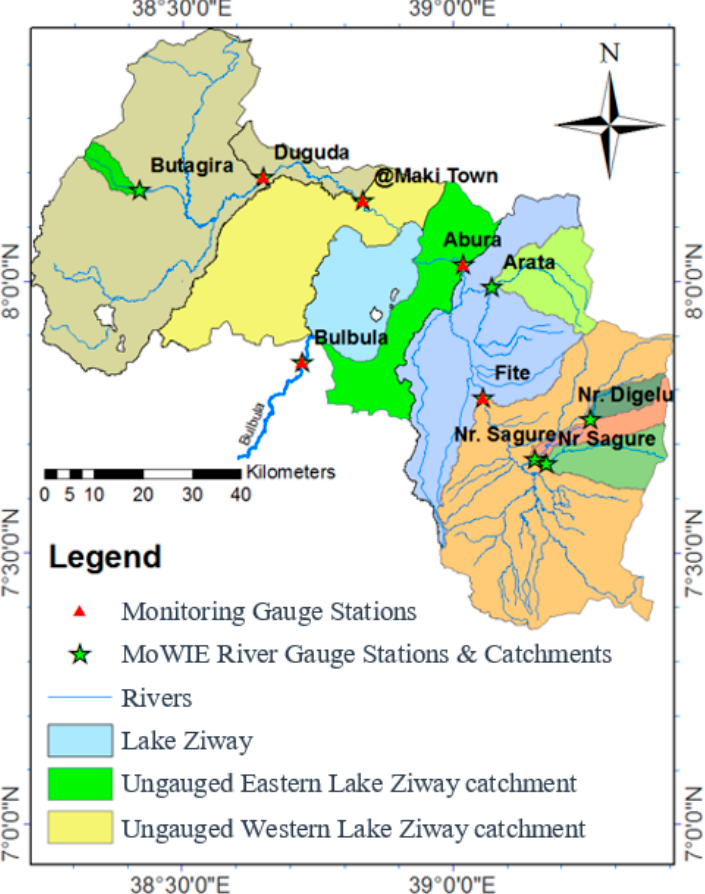
Figure 4. Ziway Lake basin river monitoring gauge stations collected from the Ethiopian Ministry of Water Irrigation and Electricity (MoWIE).